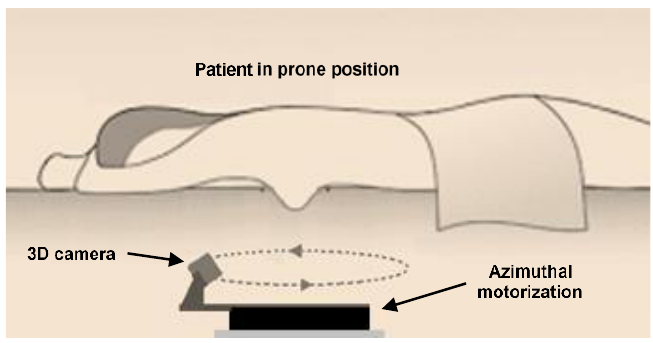
Figure 2. Internal schematic view of the OBCD subsystem.